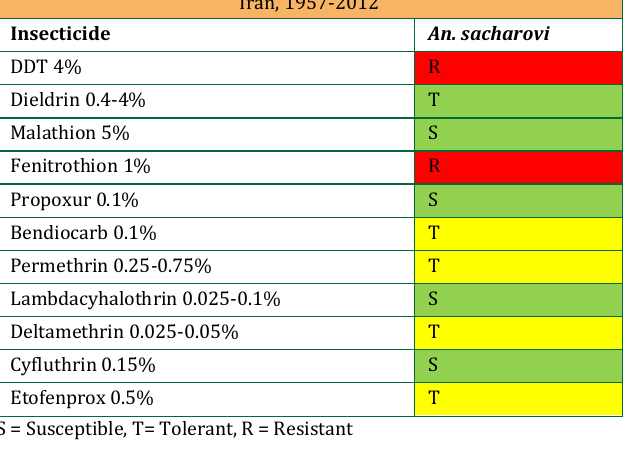
Table 1: Status of insecticide resistance in Anopheles sacharovi of